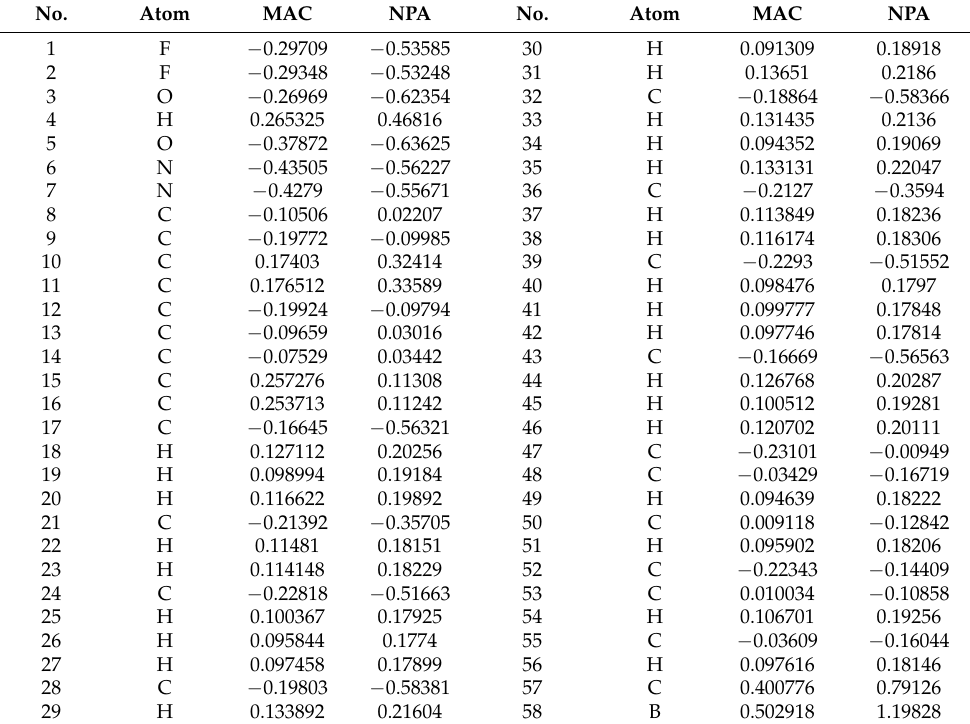
Table 3. MAC and NPA charge population.